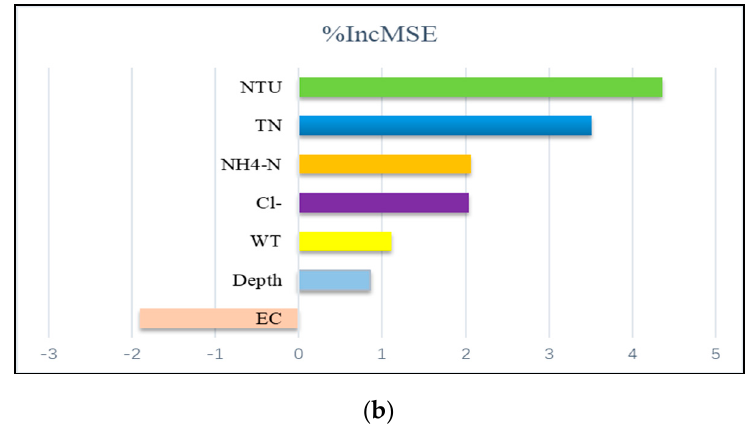
Figure 9. Effects of seven environmental drivers (Cl − , depth, NTU, DO, NH 4+ -N, TN, and WT) on phytoplankton in summer.